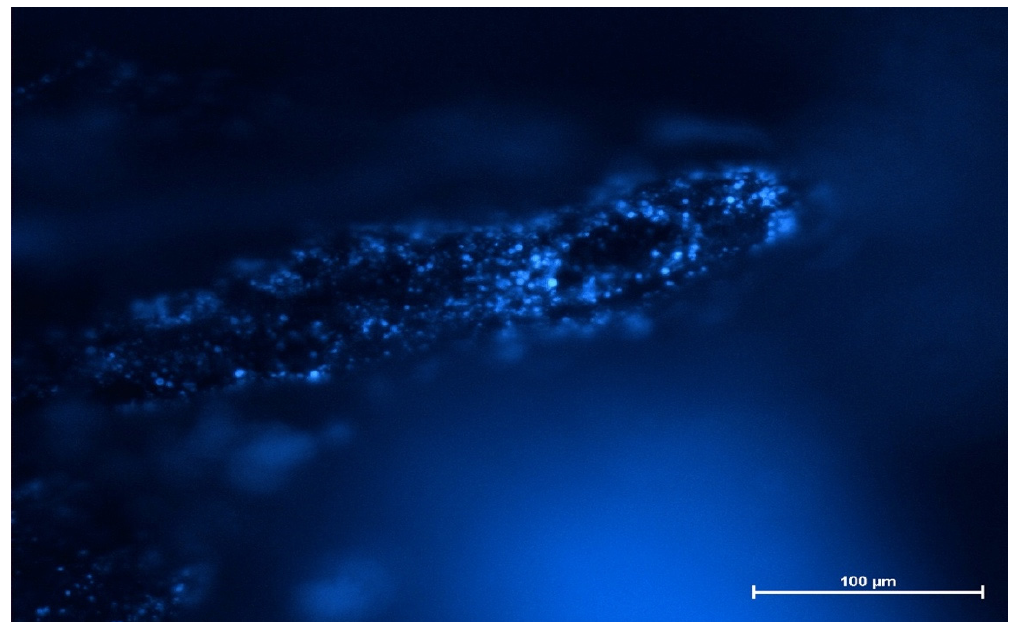
Figure 4. Preparation of rat aorta. PLA-DH microspheres immersed in the aortic wall after administration. Fluorescence microscopy image (Nikon Eclipse TE 2000-S, Japan), 100× magnification.